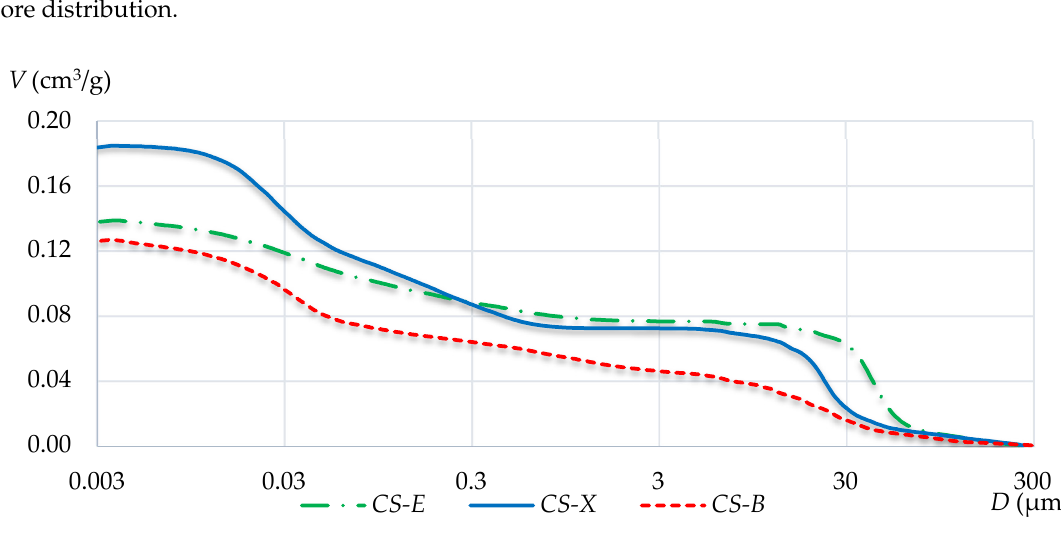
Figure 5. Integral pore distribution curves of the three tested silicates.